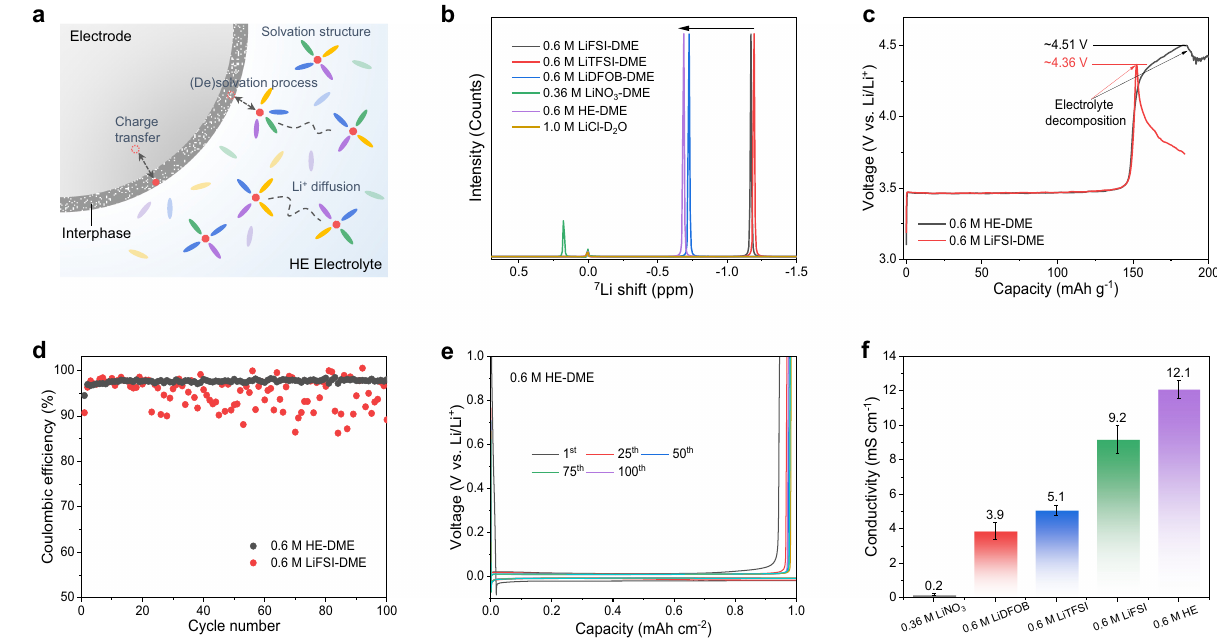
Fig. 1 | Properties of the HE liquid electrolyte. a Schematic of the HE electrolyte batterysystem. b 7 LiNMRspectraofsingle-saltelectrolytesandtheas-preparedHE electrolyte.DuetotherelativelylowsaltsolubilityofLiNO 3 inDME,a0.36MLiNO 3 - DME electrolyte was prepared for comparison. c Galvanostatic charge pro fi les of